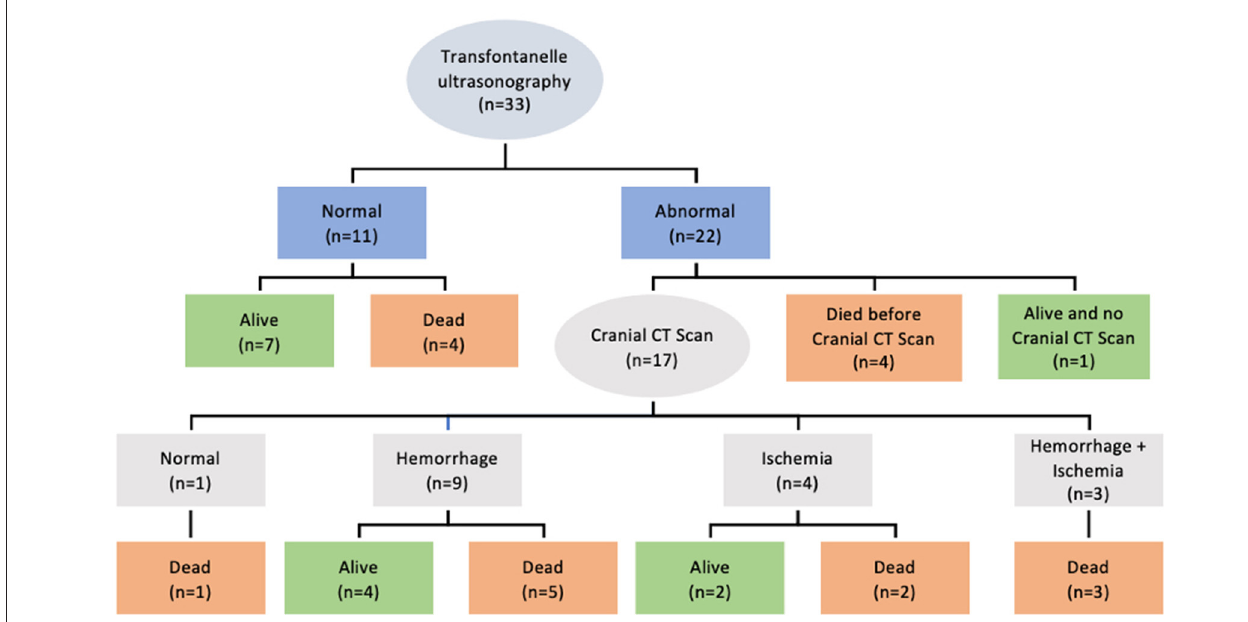
FIGURE 4 | Neurological findings in patients receiving ECMO assistance.